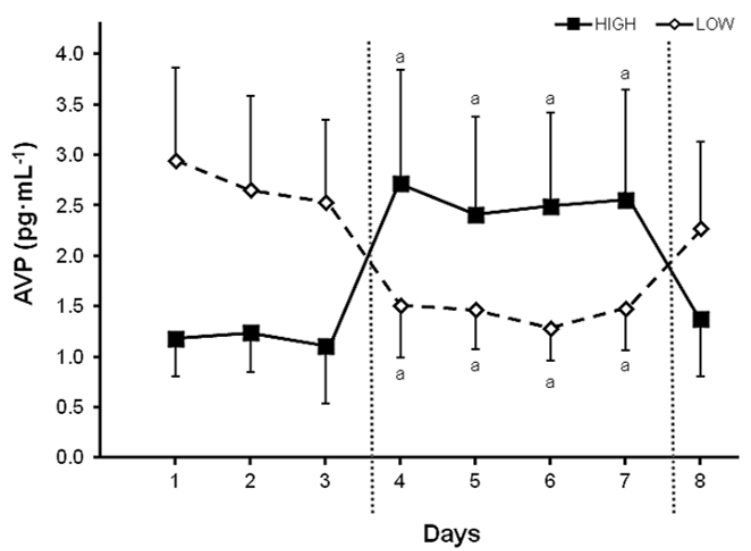
Figure 5. Morning plasma AVP concentrations of habitual high-volume drinkers (HIGH, 3.2 ± 0.6 L/24h, n = 14 ♀ ) and low-volume drinkers (LOW, 1.6 L/24h, n = 14 ♀ ) during ad libitum baseline (3 days), modified water intake (4 days; HIGH, 2.0 ± 0.2 and LOW, 3.5 ± 0.1 L/24h), and ad libitum recovery (1 day; HIGH, 3.2 ± 0.9 and LOW, 1.7 ± 0.5 L/24h). Different experimental phases are separated by vertical dotted lines. a, within-group significant difference from the 3-d baseline mean ( p < 0.001). Reprinted with permission from Johnson et al., (2016) [13].